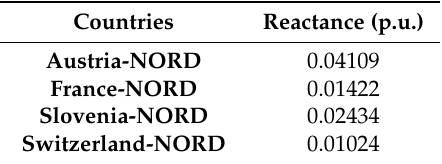
Table 5. Reactance (p.u.) of the interconnections with neighboring